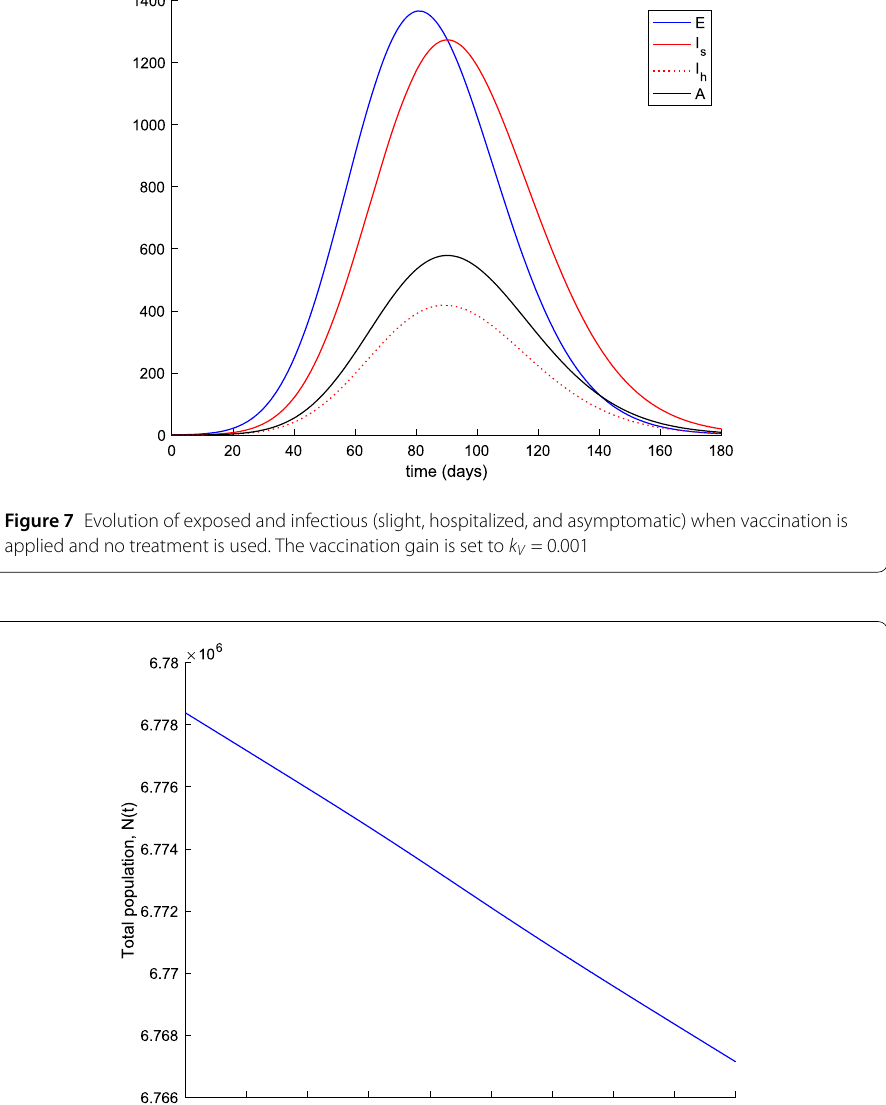
expense of higher efforts and therefore a higher cost. With the proposed model, quanti- tative prediction of the improvement and action efforts can be done as shown with the simulation results. The basic reproduction number in the absence of external actions is calculated through (23) as R (0,0) =5.78. When k T = 0, Remark 3 allows calculating the ob- tained reproduction number when a vaccination gain is applied. The shape of the curve is depicted in Fig. 17 along with the calculated values of the reproduction number for some particular vaccination gains. On the other hand, when there is no vaccination action and a treatment is applied, the basic reproduction number changes a depicted in Fig. 18. We deduce from Figs. 17 and 18 that vaccination has a stronger effect in modifying the